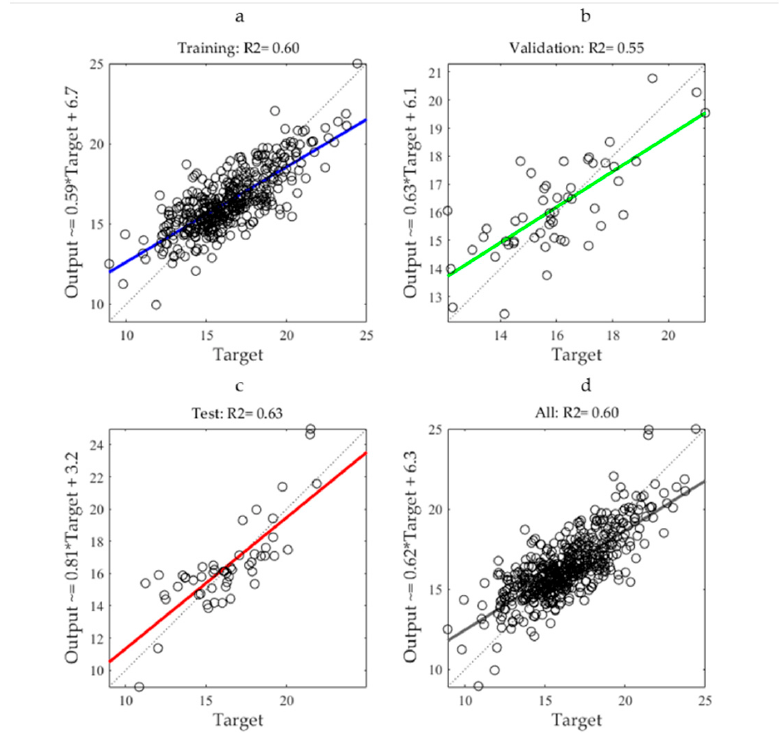
Figure 7. Linear regression between fruit fat content target values and those estimated through ANN model. Each subfigure represents the dataset of training ( a ), validation ( b ), test ( c ), and the whole dataset ( d ).